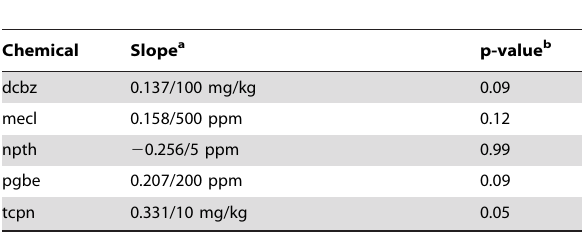
Table 6 . Slopes of the dose-response curves in Figure